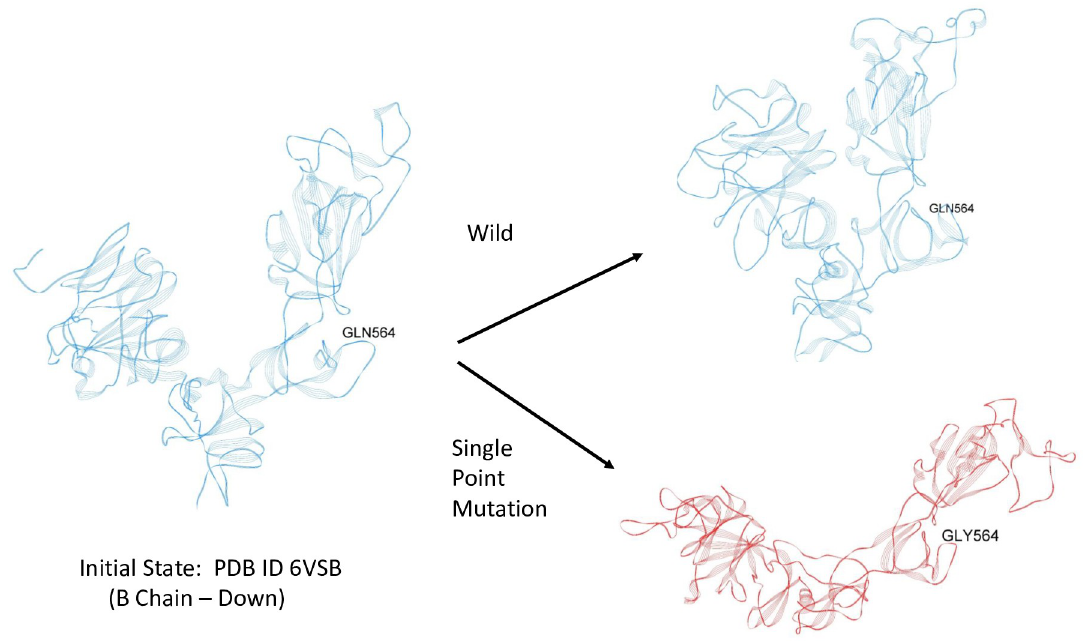
Fig 9. Initial dynamic test of possible latch over a period of approximately 0.1 μ sec. Blue—Wild; Red-Mutant. https://doi.org/10.1371/journal.pone.0241168.g009 shown in the supplemental movie S2 Video in S1 File. that demonstrate no changes in the Up or Down states of the RBD despite the quick hinge opening in the isolated protomer. Thus, even with a radical mutation that quickly unlatches an isolated Down state protomer, neigh- boring chain interactions stabilize the trimeric structure and help retain its specific conforma- tional states.